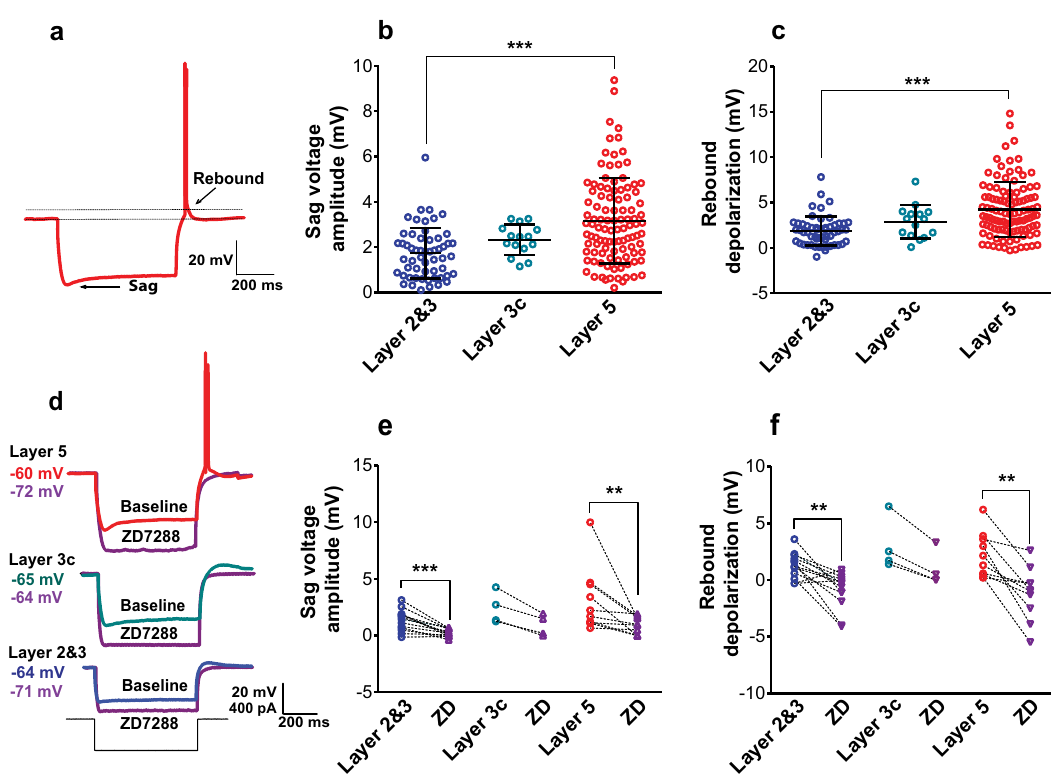
Fig. 2 I h -related membrane properties are more apparent in L5 pyramidal cells compared to L2&3 and L3c. a Example voltage sweep from a representative L5 pyramidal cell during injection of − 400 pA hyperpolarizing current step. Arrows indicate sag voltage and rebound depolarization and post-hyperpolarization rebound spiking . b , c Sag voltage amplitude ( p < 0.0001; one-way ANOVA post hoc with Dunn ’ s multiple comparison test, L2&3 ( n = 56), L3c ( n = 15), and L5 ( n = 105)) ( b ) and rebound depolarization amplitude ( p < 0.0001; one-way ANOVA post hoc with Dunn ’ s multiple comparison test, L2&3 ( n = 56), L3c ( n = 15), and L5 ( n = 105)) ( c ) among sampled L2&3, L3c, and L5 pyramidal cells in response to injection of hyperpolarizing current. Lines and error bars denote mean and SD and asterisks indicate signi fi cance of group comparison. d Example of voltage sweeps at baseline (red, green, and blue) and after (purple) bath application of the I h blocker ZD7288 (10 µ M) following injection of − 400pA. e , f Bath application